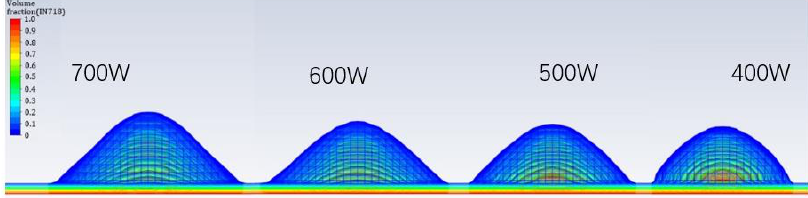
Figure 7. Simulation Results of Powder Deposition Layer Shape at Different Laser Powers.